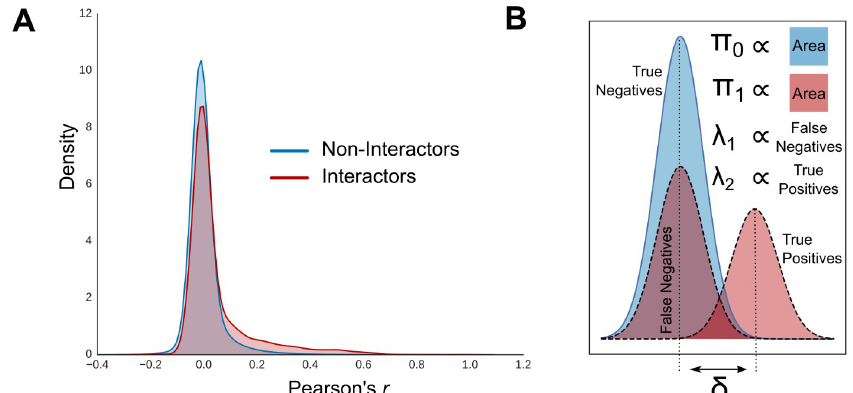
Fig 2. Simulation strategy. A.) The distribution of Pearson’s correlation coefficient averaged over 32 co-fractionation experiments on human cell lines. The distribution for gold-standard interacting human protein pairs is barely distinguishable from non-interactors. B.) Error models parameters were manipulated to replicate typical experimental noise. The equilibrium frequencies of the two state, π 0 and π 1 , can be tuned to replicate class-imbalance. The difference between the means δ , was changed to replicate weak signal. The mixture weights for the positive error model, λ 1 and λ 2 , set the false negative